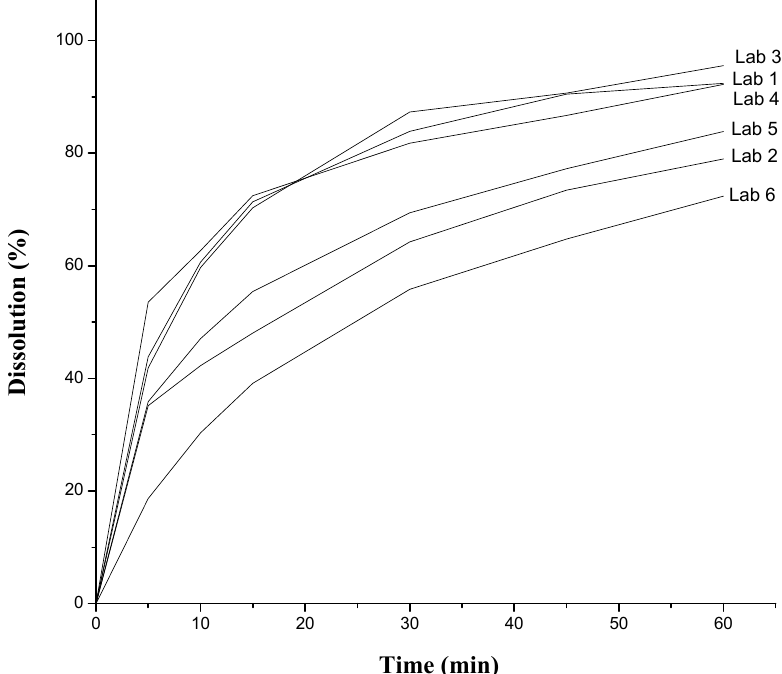
Figure 1. Dissolution profile of the six laboratory products evaluated.